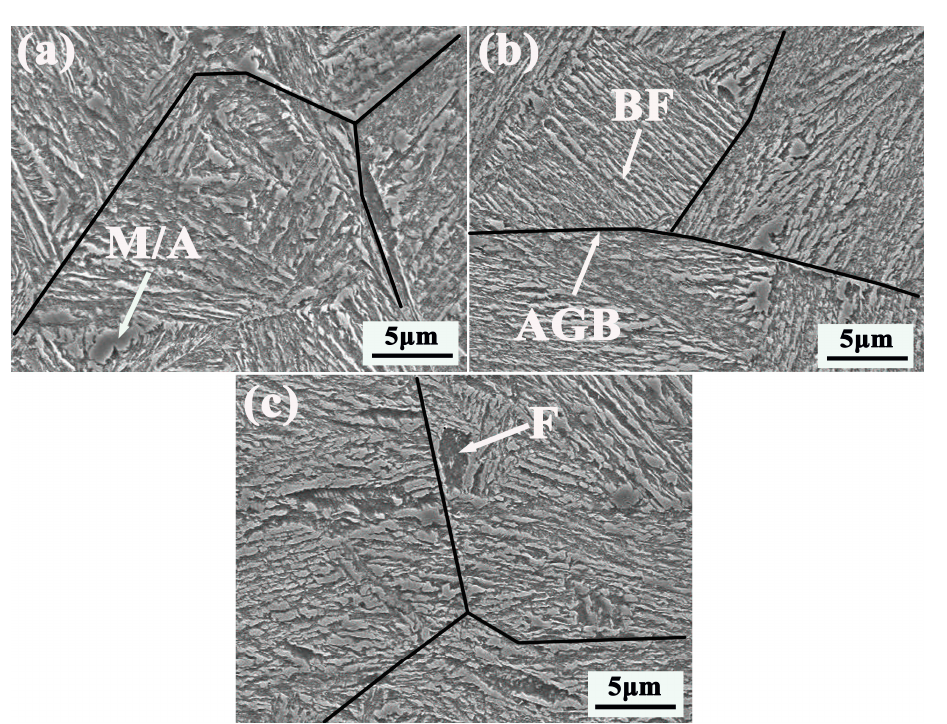
Table 2. Prior ‐ austenite grain sizes of three steels ( μ m)